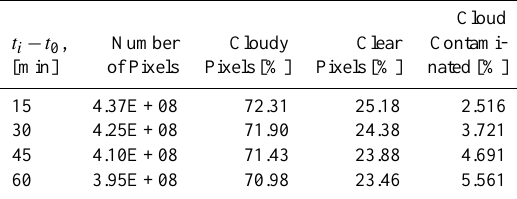
Table 1a. Statistics for Case A from MSG SEVIRI. Table 1b. Statistics for Case B from MSG SEVIRI.